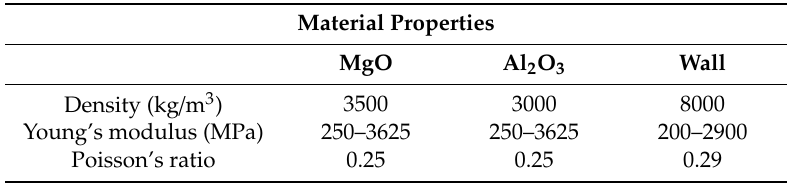
Table 1. Summary of material properties used in DEM simulations.